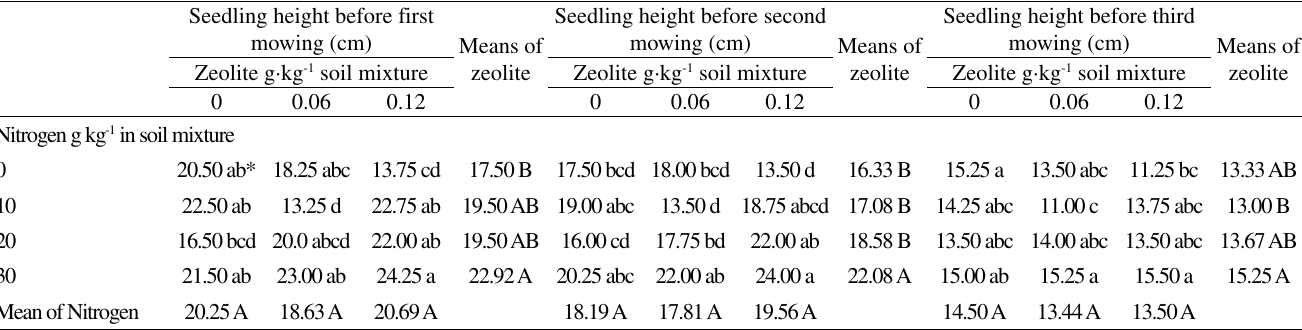
* In each column and row means followed by the same letter(s) (small letters for means and capital letters for means of rows and columns) are not significantly different using LSD test at 5% level.